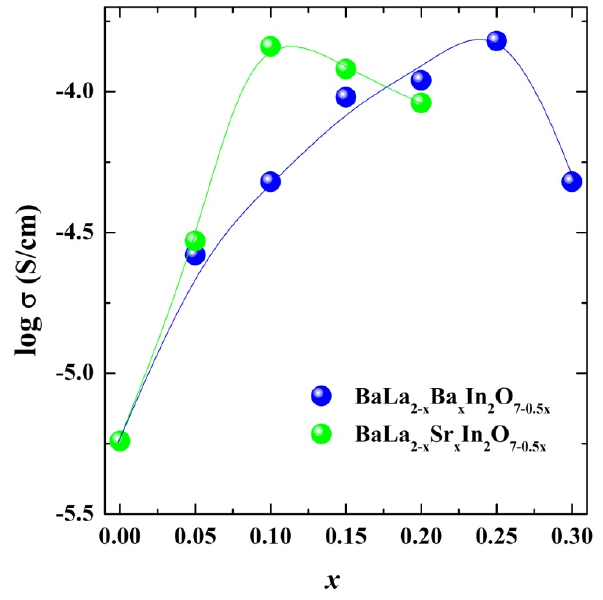
Figure 5. The concentration dependencies of electrical conductivity at 500 °C under dry air for the solid solutions BaLa 2 − x M x In 2 O 7 − 0.5 x (M = Sr, Ba). The σ− pO 2 dependencies obtained under dry and wet conditions for the doped compositions are presented in Figure 6. All dependencies for Sr and Ba compositions have the same regularities, which are discussed below. It should be noted that the shape of σ− pO 2 dependencies for undoped and doped compositions are also similar [54].